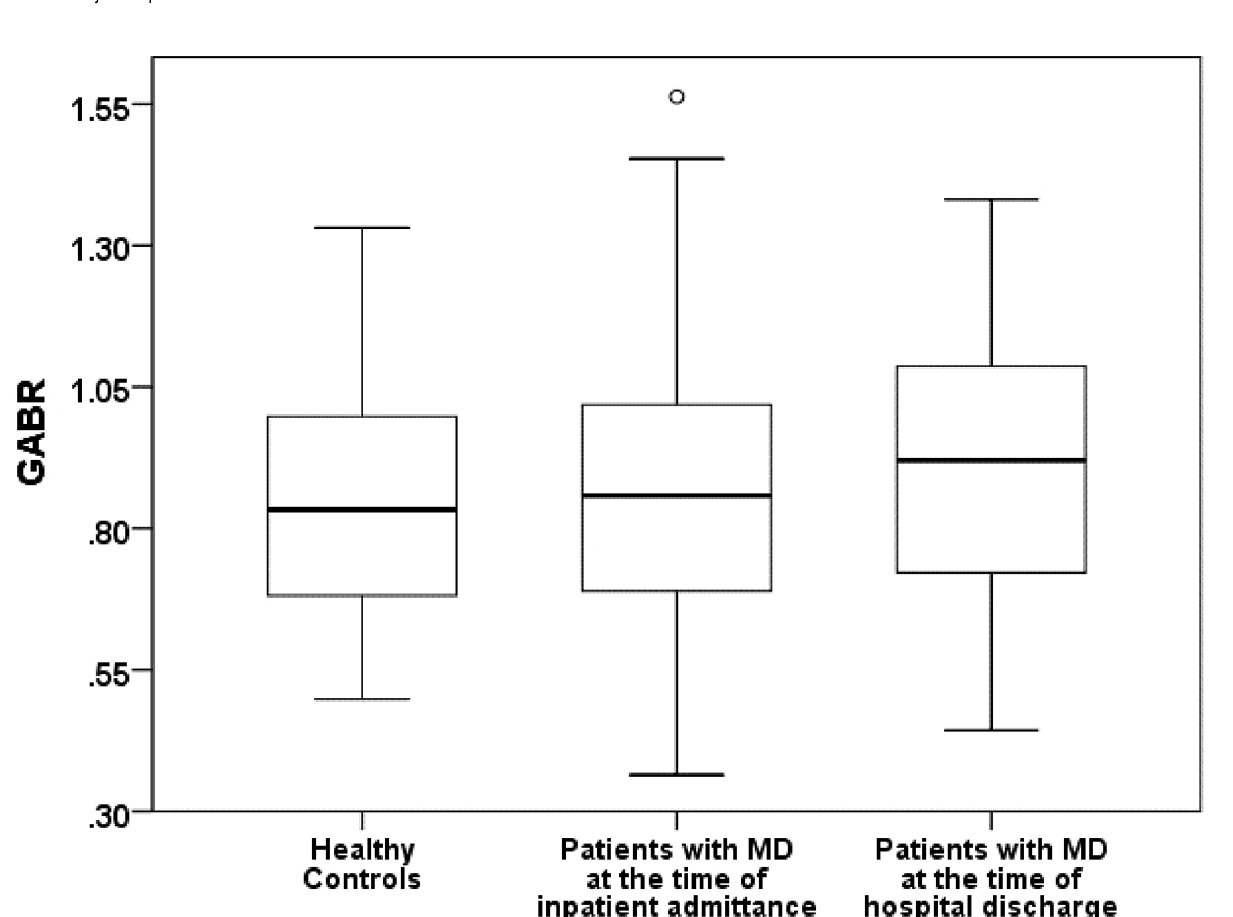
Fig 1. Comparison of the Global Arginine Bioavailability (GABR) between healthy contols and patients with major depression